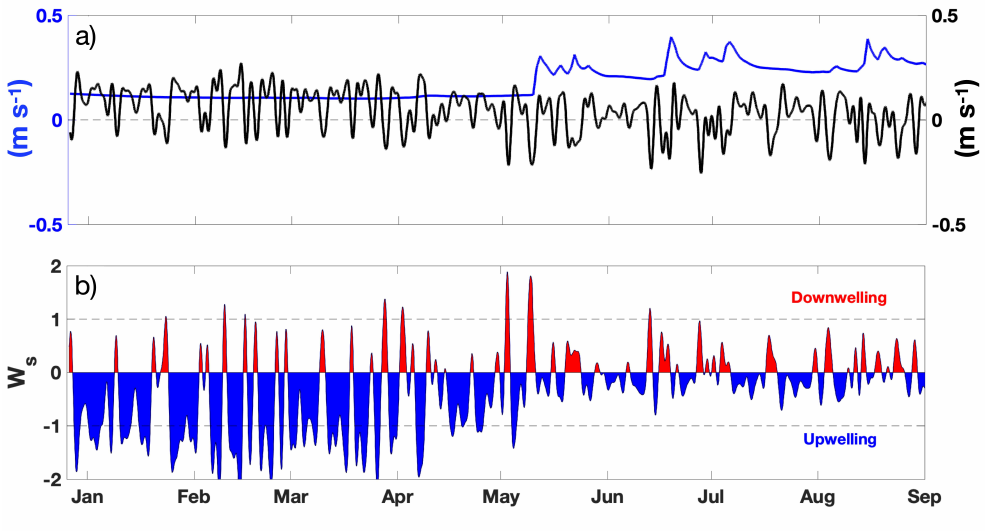
Figure 9. Wind index. ( a ) Time series of u dis (blue line) and u wind (black line). ( b ) Time series of Wind index, W s . Blue and red areas denote upwelling- and downwelling-favorable u wind values,